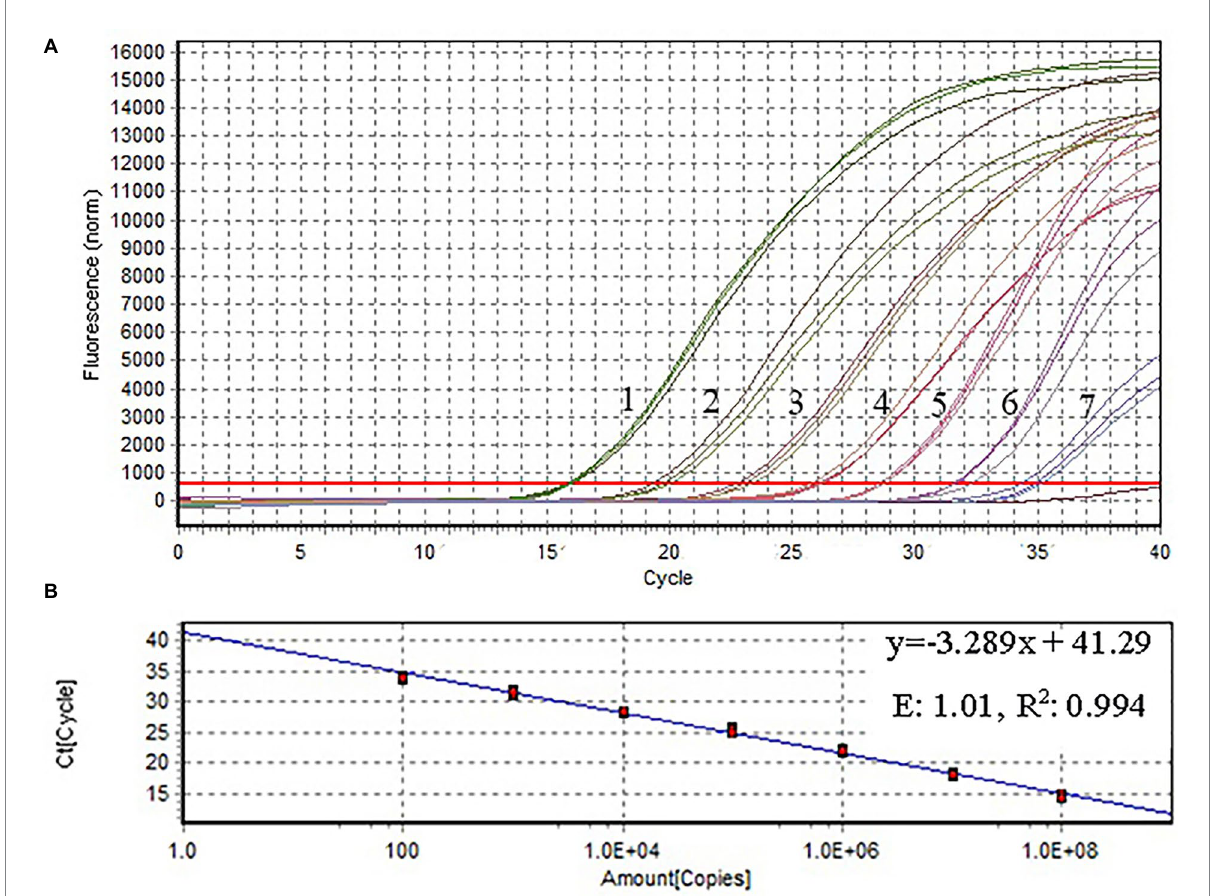
FIGURE 4 Amplification plot and standard curve of qPCR. The X -and Y -axes represent copies of the plasmids, and cycle threshold (Ct), respectively. R 2 : coefficient of determination; E: efficiency. The assay was performed using serial 10-fold dilutions of the plasmid DNA standard (1.29 × 10 8 –1.29 × 10 2 copies/ μ l). Plasmid concentration and threshold cycles had a linear relationship. The lowest copy number that could be determined by qPCR was 1.29 × 10 2 copies/ μ